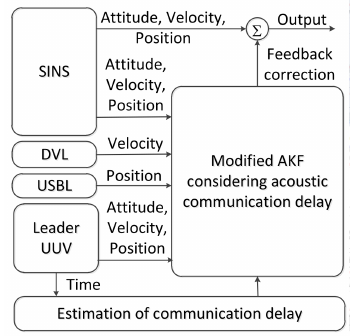
Figure 4. The schematic diagram of polar cooperative navigation of multi-UUVs considering communication